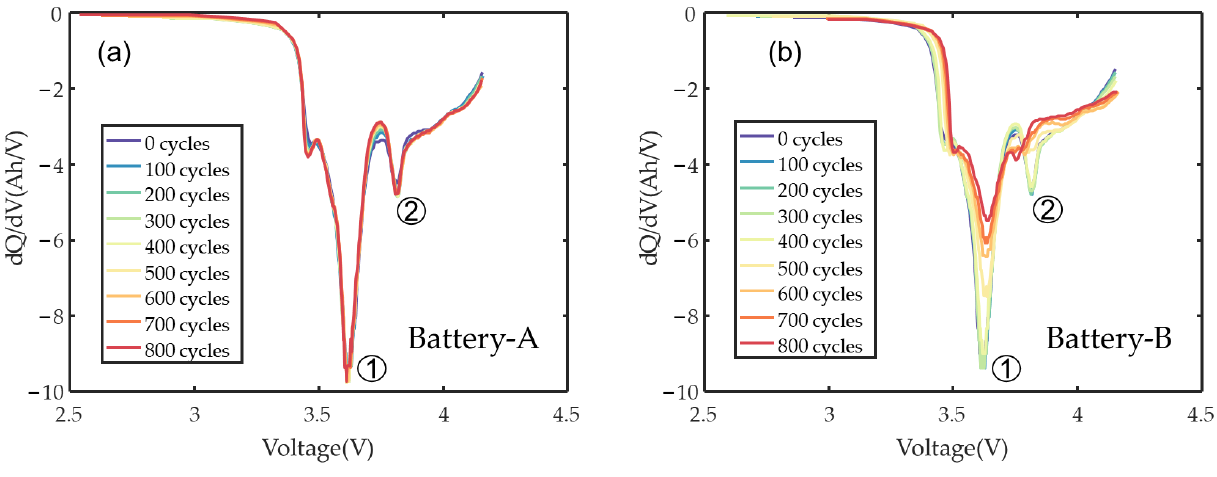
Figure 11. The evolution of the IC curves: ( a ) Battery A; ( b ) Battery B.